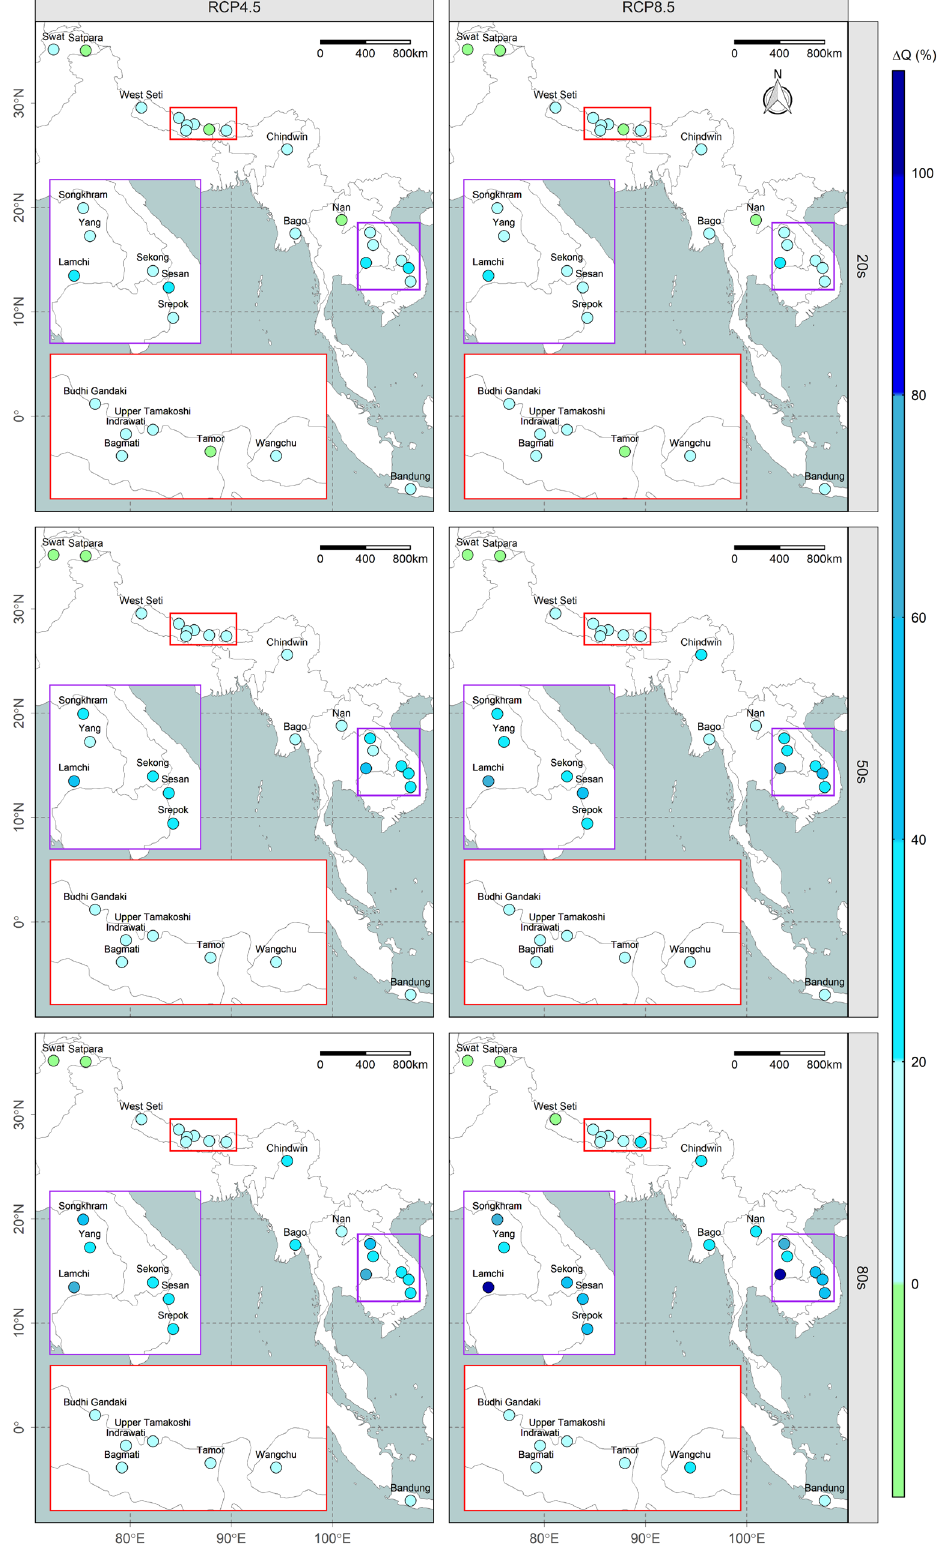
Figure 4. Spatiotemporal variation in the annual river discharge anomaly (% change). The results are from ensemble of GCMs, and each facet corresponds to different emission scenarios (RCP4.5 or RCP8.5) during different time periods (20 s, 50 s, or 80 s) as indicated at the top and left side of the map, respectively while the two insets are enlarged and colour-coded 20–22